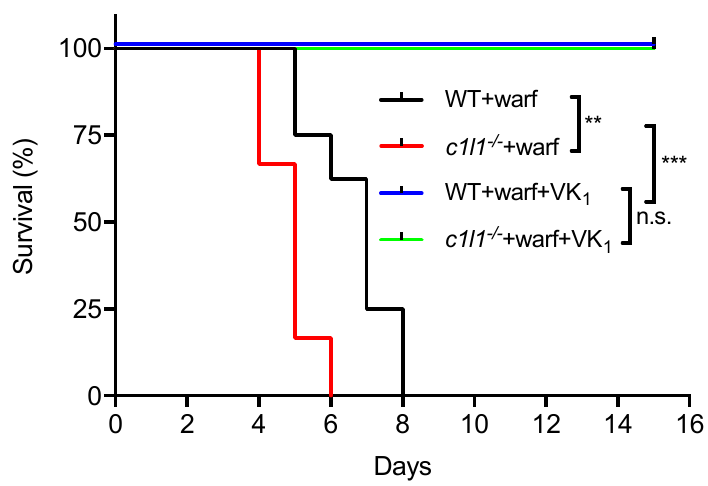
Figure 5. Genetic evidence that VKORC1L1 is not the warfarin resistant vitamin K quinone reductase present in the liver. Kaplan-Meier survival curves were determined for WT ( n = 8) and Vkorc1l1 − / − ( c1l1 ; n = 6) mice, treated with either warfarin alone (150 mg/kg/day) or a combination of warfarin (warf; 150 mg/kg/day) and vitamin K 1 (VK 1 ; 15 mg/kg/day) for a maximum of 15 days (Mantel-Cox test, ** p < 0.01 and *** p < 0.001). WT: Wild-type; c1l1 : Vkorc1l1 ; Warf: Warfarin; VK 1 ; Vitamin K 1 .